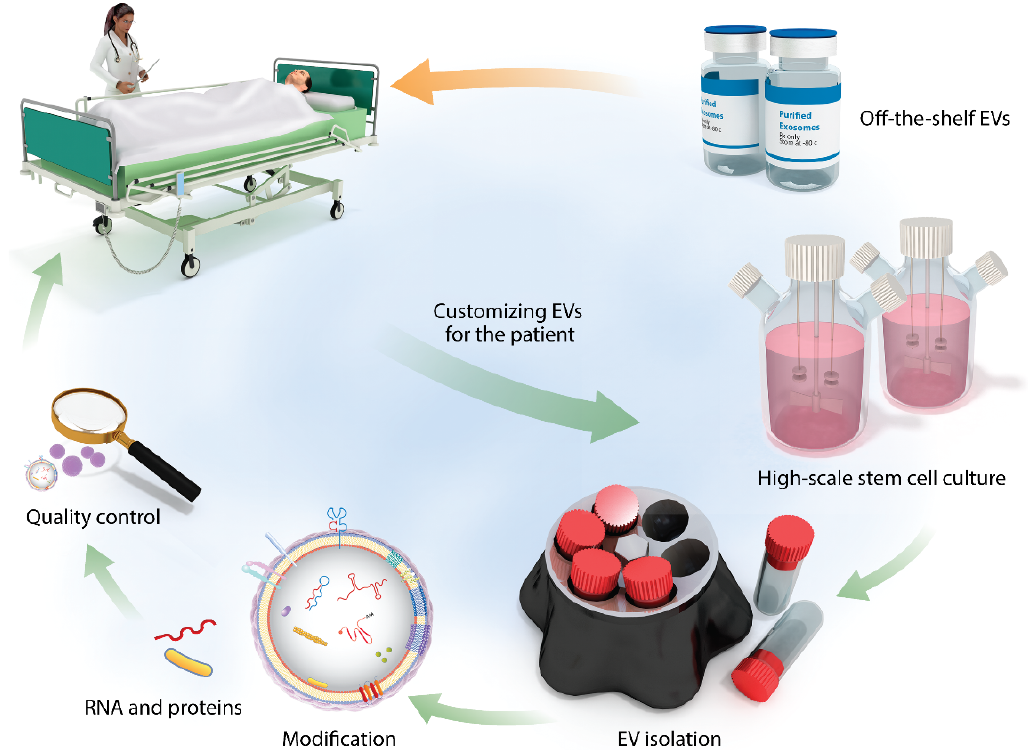
Figure 3. The process of EVs designed, manufactured, and quality controlled beforehand for clinical applications [137].